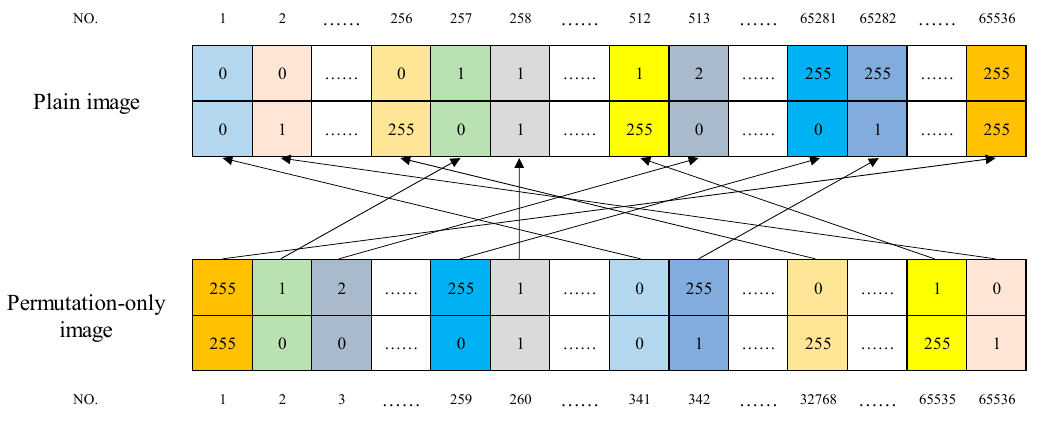
Figure 5. A schematic diagram of permutation correspondence.